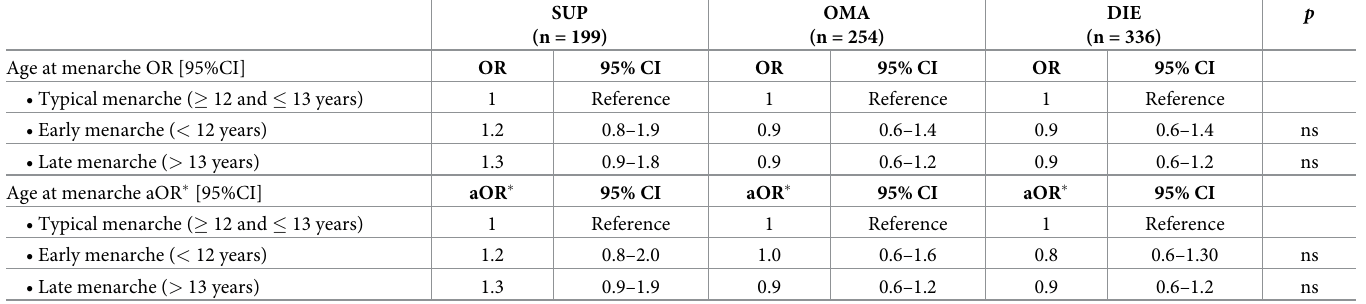
Table 3. Age at menarche and endometriosis: Comparison according to the disease phenotype (SUP, OMA, and DIE).